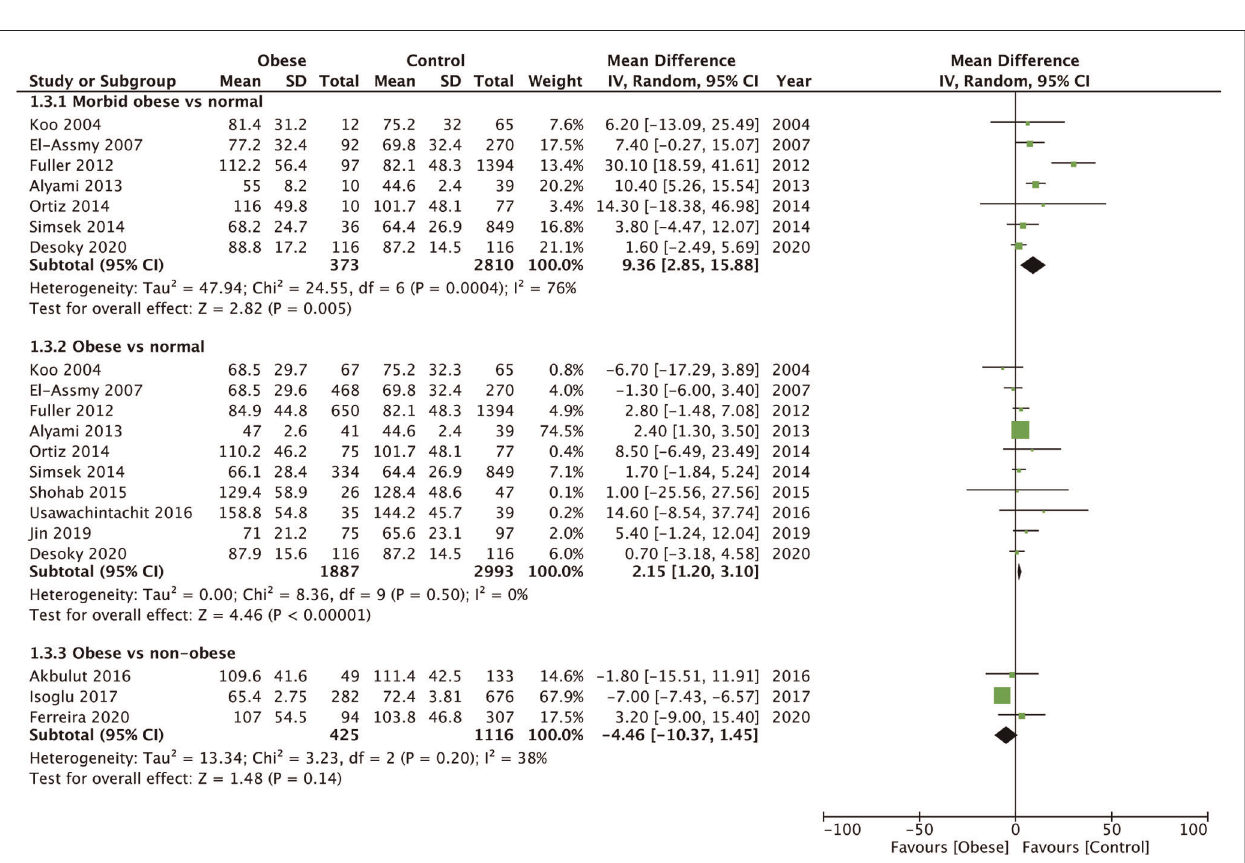
FIGURE 4 | Meta-analysis of operation time between morbid obese vs normal, Obese vs normal, and obese vs non-obese